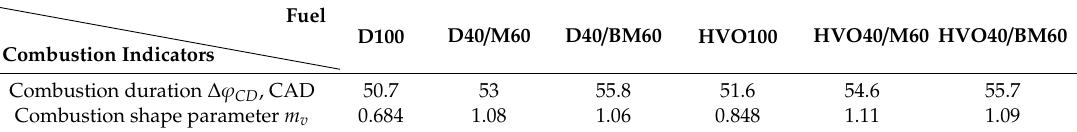
Table 5. Combustion indicators of fuel